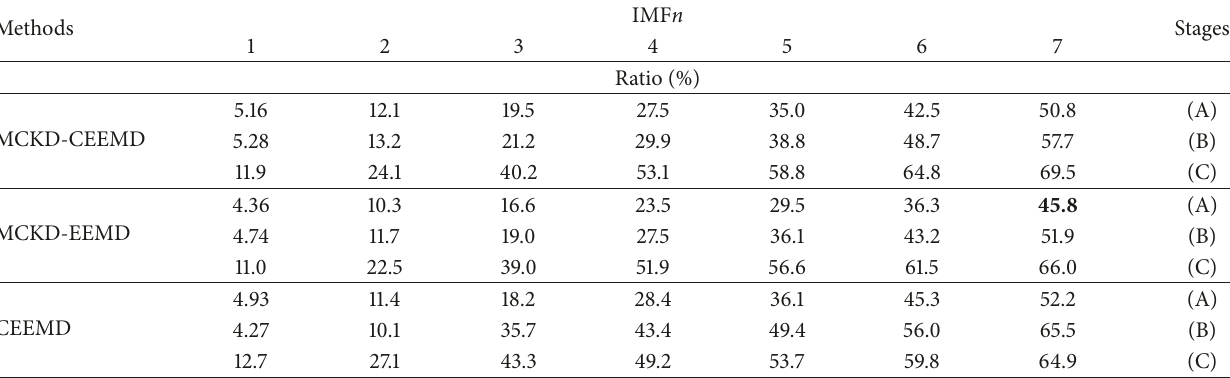
Table 1: Ratio of parameter: